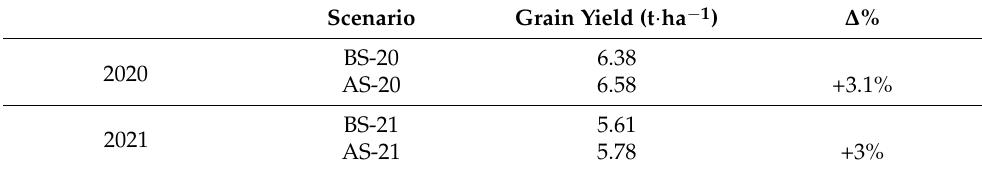
Figure 1. System boundaries graphical representation: the diagram shows all the operations included in the LCA study with the related inputs. O: organic fertilizer; NPK: mineral fertilizer; H: herbicide; S: seed; F: fungicide. Table 1. Primary data regarding grain yield at commercial moisture (14%).